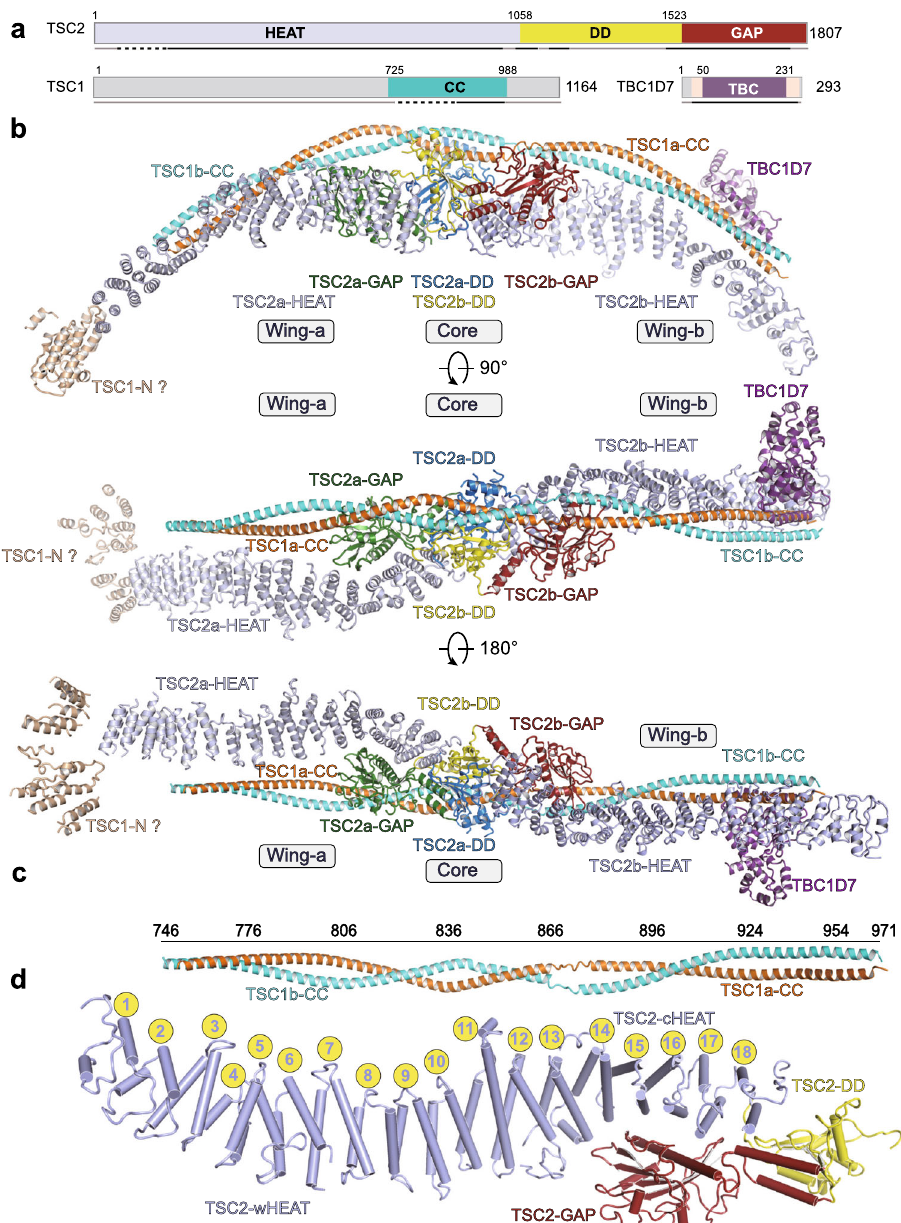
Fig. 1 Overall structure of human TSC complex. a Color-coded domain structure of the three subunits with invisible regions colored in gray. Residues at domain boundaries are indicated with numbers. The same color scheme is used throughout all structure fi gures unless indicated elsewhere. HEAT: HEAT repeat domain, GAP: GTPase-activating domain, CC: coiled coil, DD: dimerization domain, TBC Tre2-Bub2-Cdc16 domain. Residues at domain boundaries are indicated. Unmodeled regions are indicated with gray lines under each protein. Solid black and dashed black lines below indicate regions that were modeled with residues and poly alanine, respectively. b Ribbon representation of TSC complex structure in three different views. The modules and subunits are labeled and indicated. c TSC1 coiled-coil dimer structure with residue positions indicated. d Cartoon model of one of TSC2 monomer, the HEAT repeats are indicated with numbered